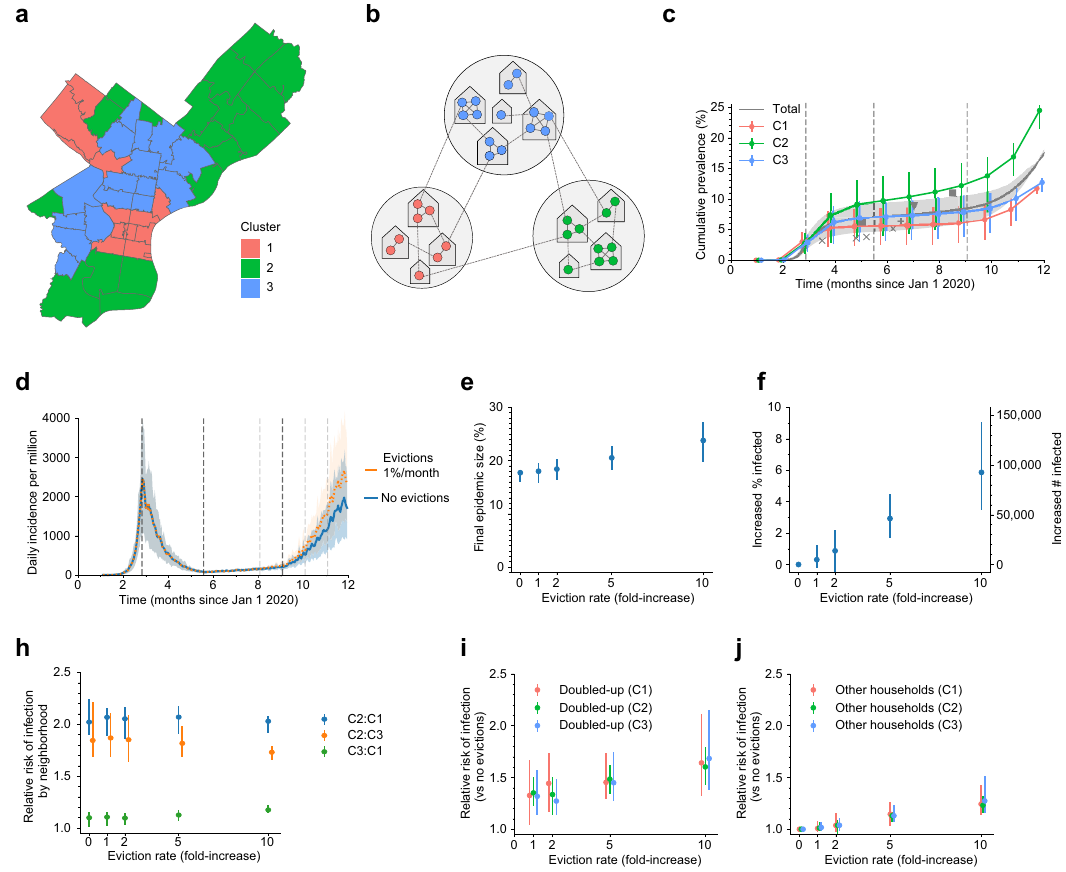
Fig. 5 A detailed example of how evictions might affect SARS-CoV-2 transmission in the city of Philadelphia, Pennsylvania, USA. a Map of Philadelphia, with each zip code colored by the cluster it was assigned to. Properties of clusters are Table 2 and Supplementary Tables 1, 2. b Schematic of our model for inequalities within the city. Each cluster is modeled as a group of households, and the eviction rate and ability to adopt social distancing measures vary by cluster. c Simulated cumulative percent of the population infected over time, by cluster, in the absence of evictions. Data points from seroprevalence studies in Philadelphia or Pennsylvania: x 50 , + 35 , triangle 49 , square 36 . d The projected daily incidence of new infections (7-day running average) with evictions at 5-fold the 2019 rate vs. no evictions. Shaded regions represent central 90% of all simulations. e Final epidemic size by Dec 31, 2020, measured as percent individuals who had ever been in any stage of infection. f The predicted increase in infections due to evictions through Dec 31, 2020, measured as the excess percent of the population infected (left Y -axis) or the number of excess infections (right Y -axis). g Relative risk of infection by Dec 31, 2020, for residents compared by neighborhood. h – i Relative risk of infection by Dec 31, 2020, in the presence vs. absence of evictions, for individuals who merged households due to evictions ( “ Doubled-up ” , h ) and for individuals who kept their pre-epidemic household ( “ Other households ” , i ). Data in c , e – i showed as median values with interquartile ranges across